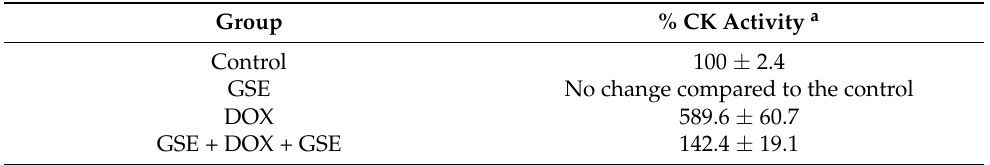
Table 3. Creatine kinase (CK) activity in mice treated with DOX in combination with grape seed extract (GSE) [37].